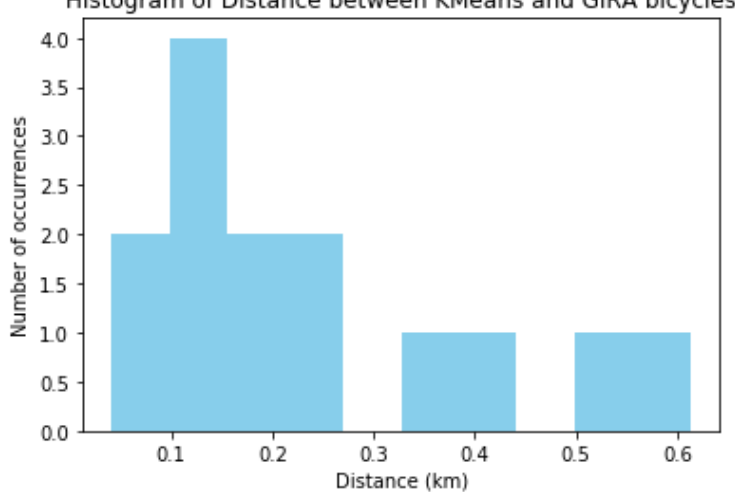
Figure 12. Histogram of Distances comparison for K-Means and GIRA stations.